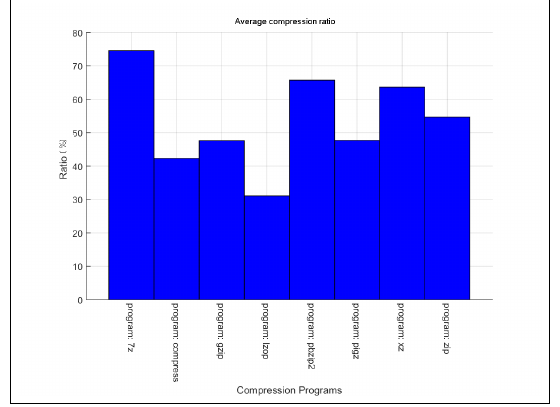
Figure 6: Graph of maximum and minimum of the achieveable compression ratio.